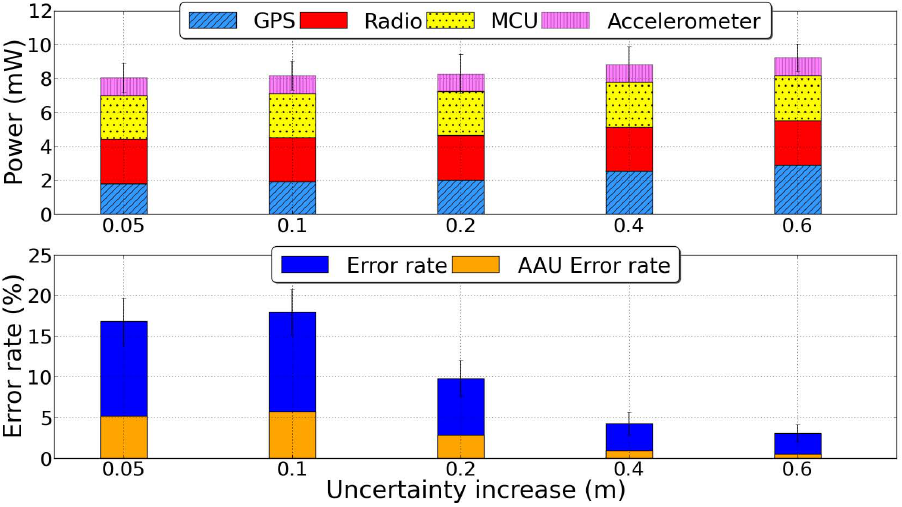
Figure 11. The effect of varying s S . Lower values reduce the GPS duty cycle, as the uncertainty reaches AAU less often, yet increase the error rate. Higher s decrease in positioning errors at a slightly higher power consumption for added GPS